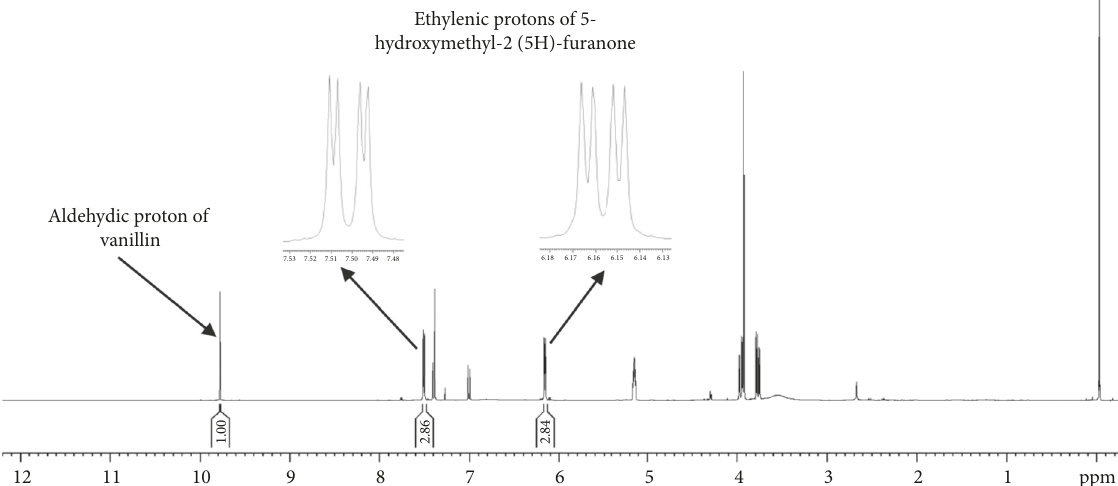
Figure 3: 1 H NMR spectrum of the Helleborus lividus subsp. corsicus dichloromethane leaf extract.